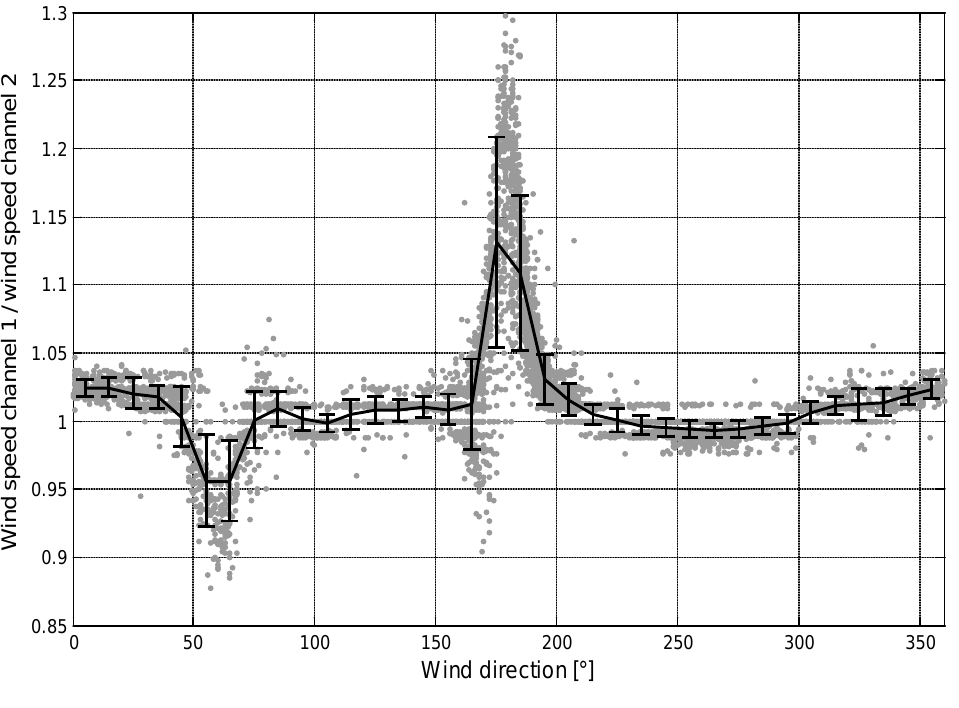
Figure 9. Ratio of wind speed readings recorded by a pair of anemometers mounted on a lattice tower. The continuous line represents bin-averages for a bin width of 10°. Error bars correspond to ± one standard